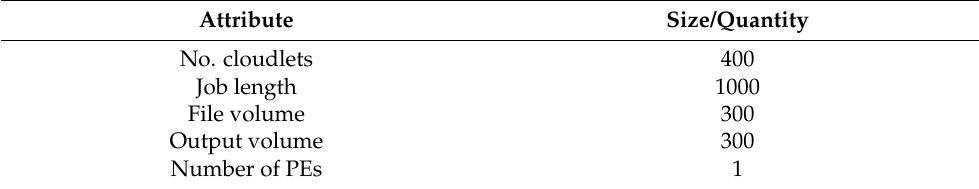
Table 3. Job Attributes.